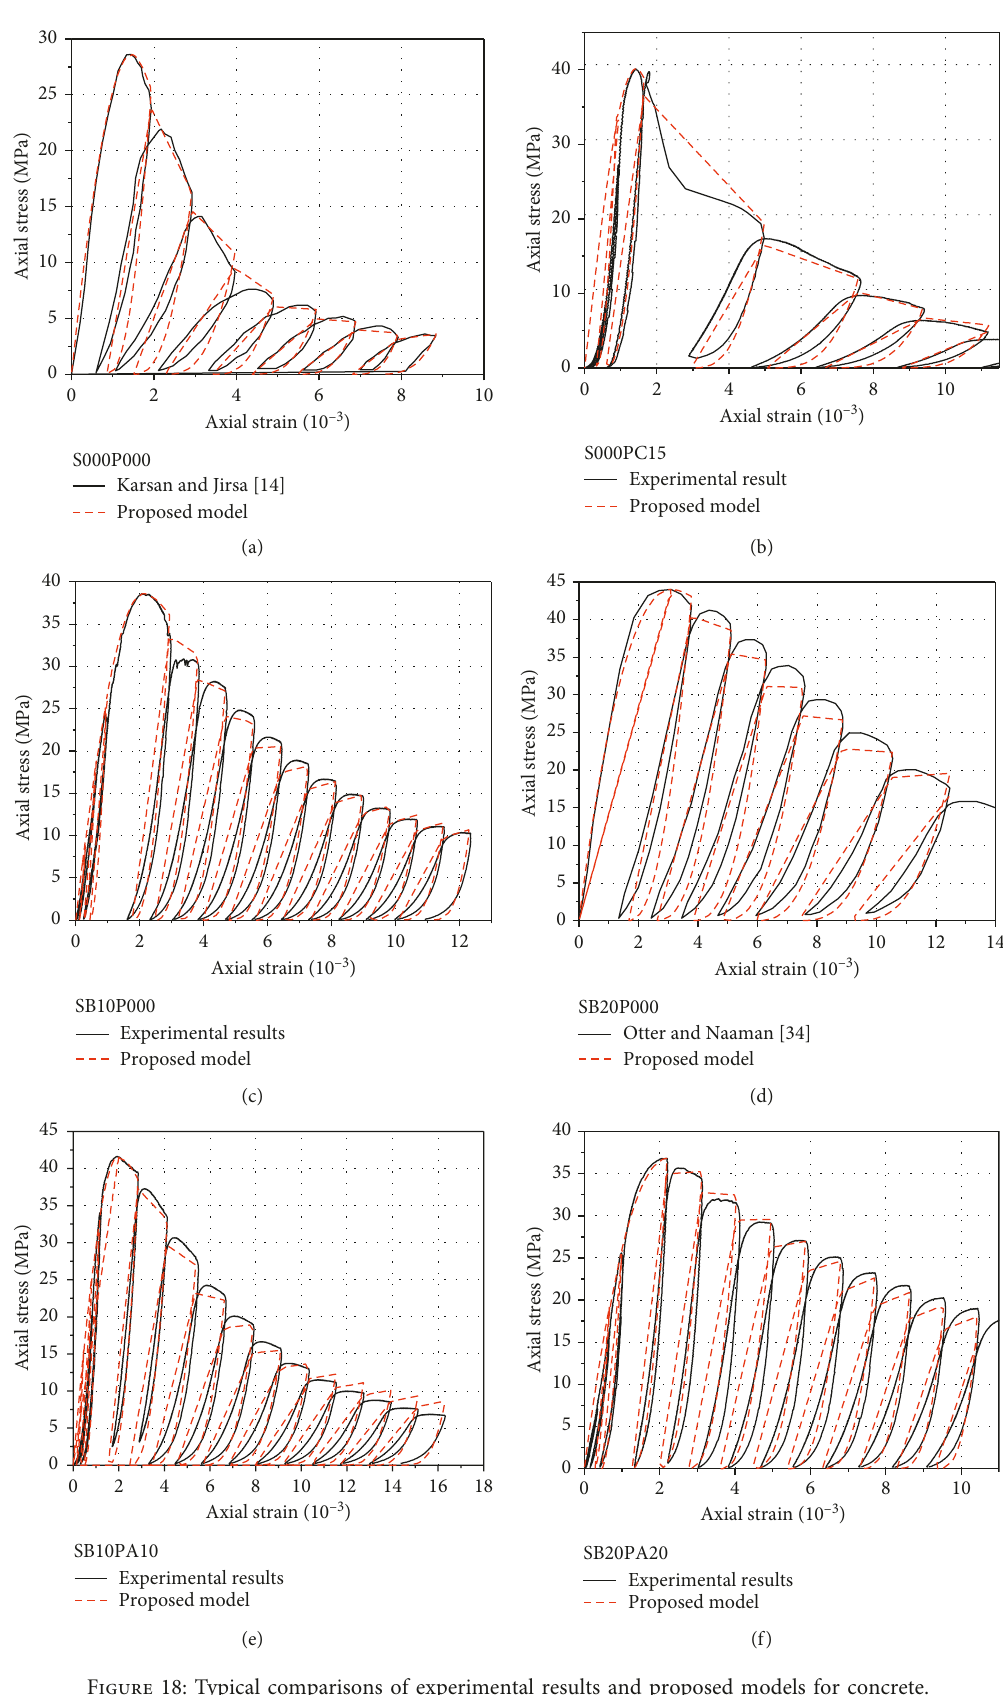
Figure 18: Typical comparisons of experimental results and proposed models for